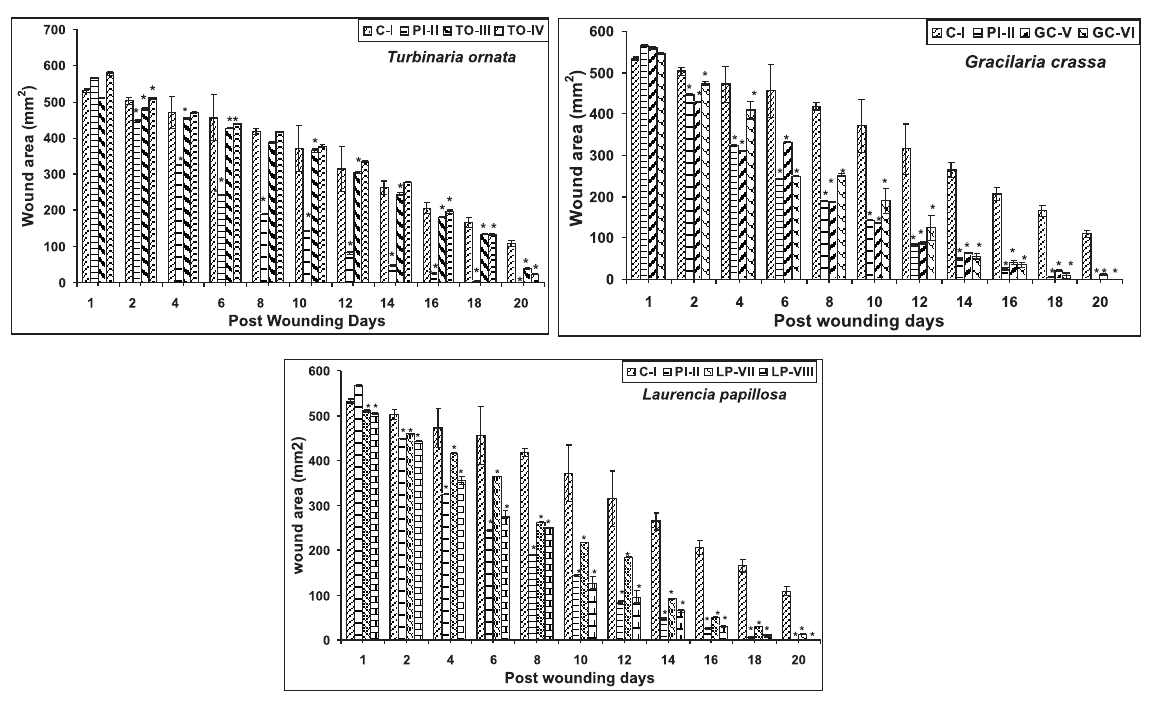
FIGURE 2 - Wound healing activity of seaweed Turbinaria ornata , Gracilaria crassa and Laurencia papillosa acetone extracts. (Values: mean±SD of four replicates; *P<0.05 compared to control; C-Control; PI-Povidone Iodine ointment (5% w/w); TO- Turbinaria ornata ; GC- Gracilaria crassa ; LP- Laurencia papillosa ; I-VIII - animal groups; TO-III, GC-V, LP-VII-100 mg/kg; TO-IV, GC-VI, LP-VIII-200